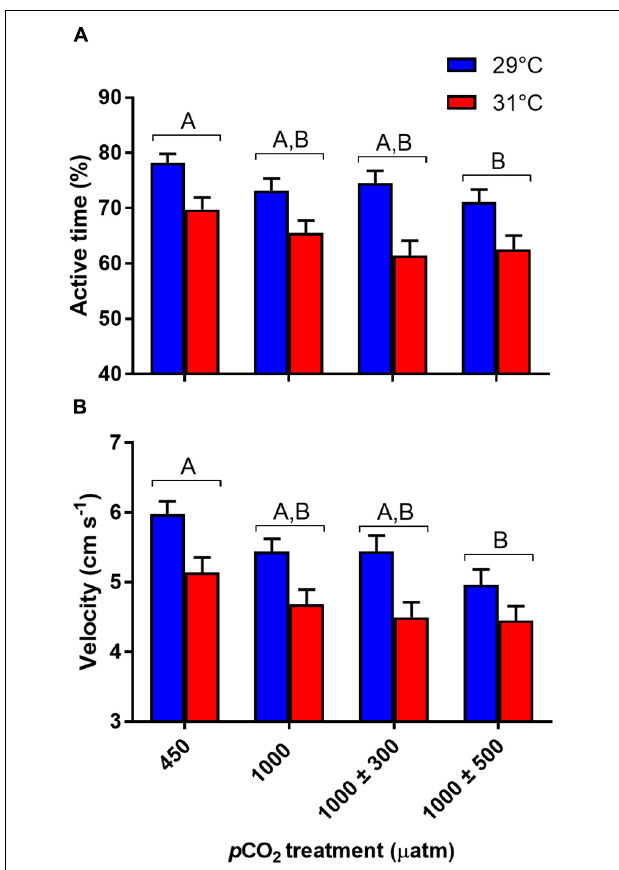
FIGURE 4 | Effects of elevated CO 2 and temperature on the boldness traits of juvenile A. polyacanthus . (A) Number of visits to center zone. (B) Time spent in center zone. Bars represent means ±